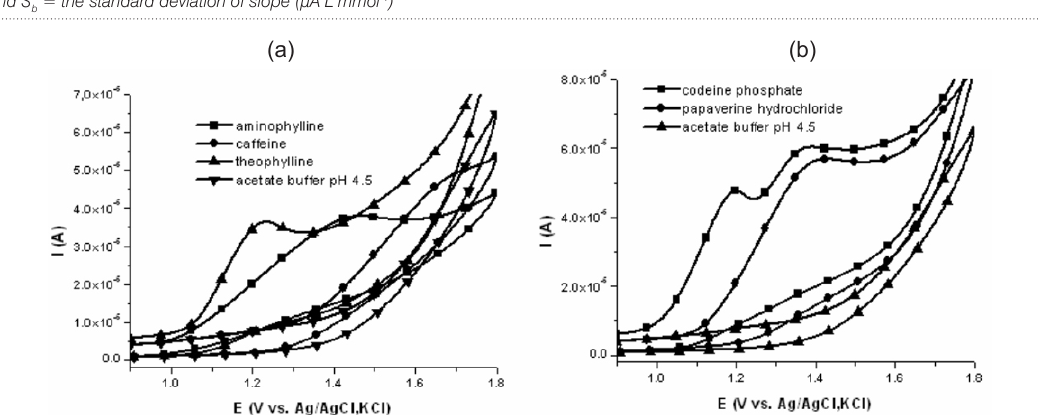
Figure 3. Cyclic voltammograms of 10 -3 mol L -1 : (a) purine alkaloids (aminophylline, theophylline and caffeine); (b) codeine phosphate and papaverine hydrochloride solutions in 0.2 mol L -1 acetate buffer pH 4.5 on electrochemically activated glassy carbon electrode (reference